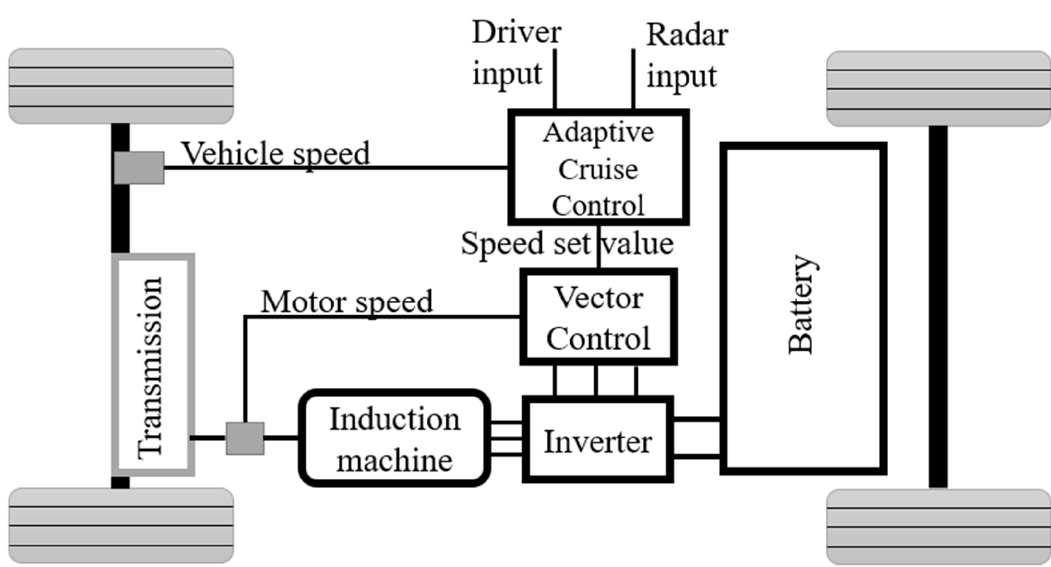
Figure 3. EV propulsion system with adaptive cruise control.